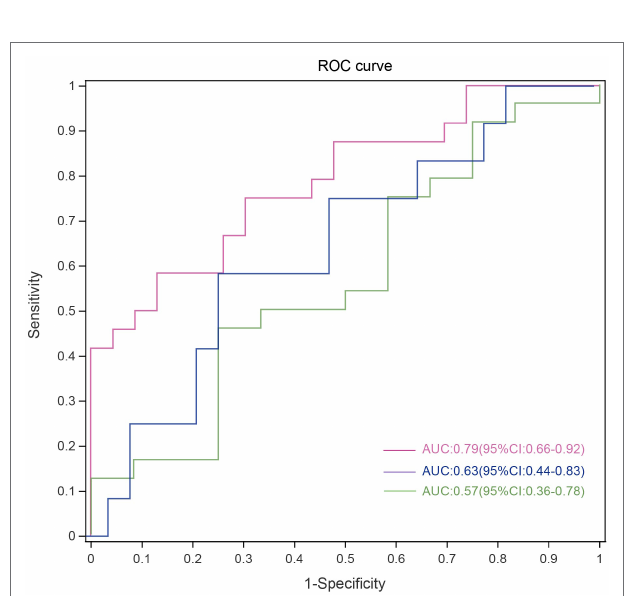
FIGURE 4 | Disease malignancy based on oral microbiome signature. ROC curves evaluating ability to predict tumor malignancy patients based on 5 significantly altered genera. Each curve represents the sensitivity and specificity to distinguish subjects with HGG (red line), LGG (green line) from HCs, while the blue line represents sensitivity and specificity between LGG and HGG. ROC, receiver operating characteristic; HGG, high-grade glioma; LGG, low-grade glioma; HCs, healthy